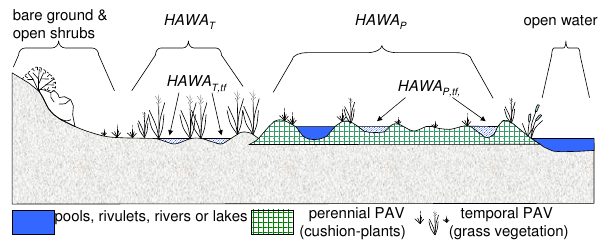
Fig. 2. Schematic cross-cut through an ideal HAWA (modified after Ruthsatz,